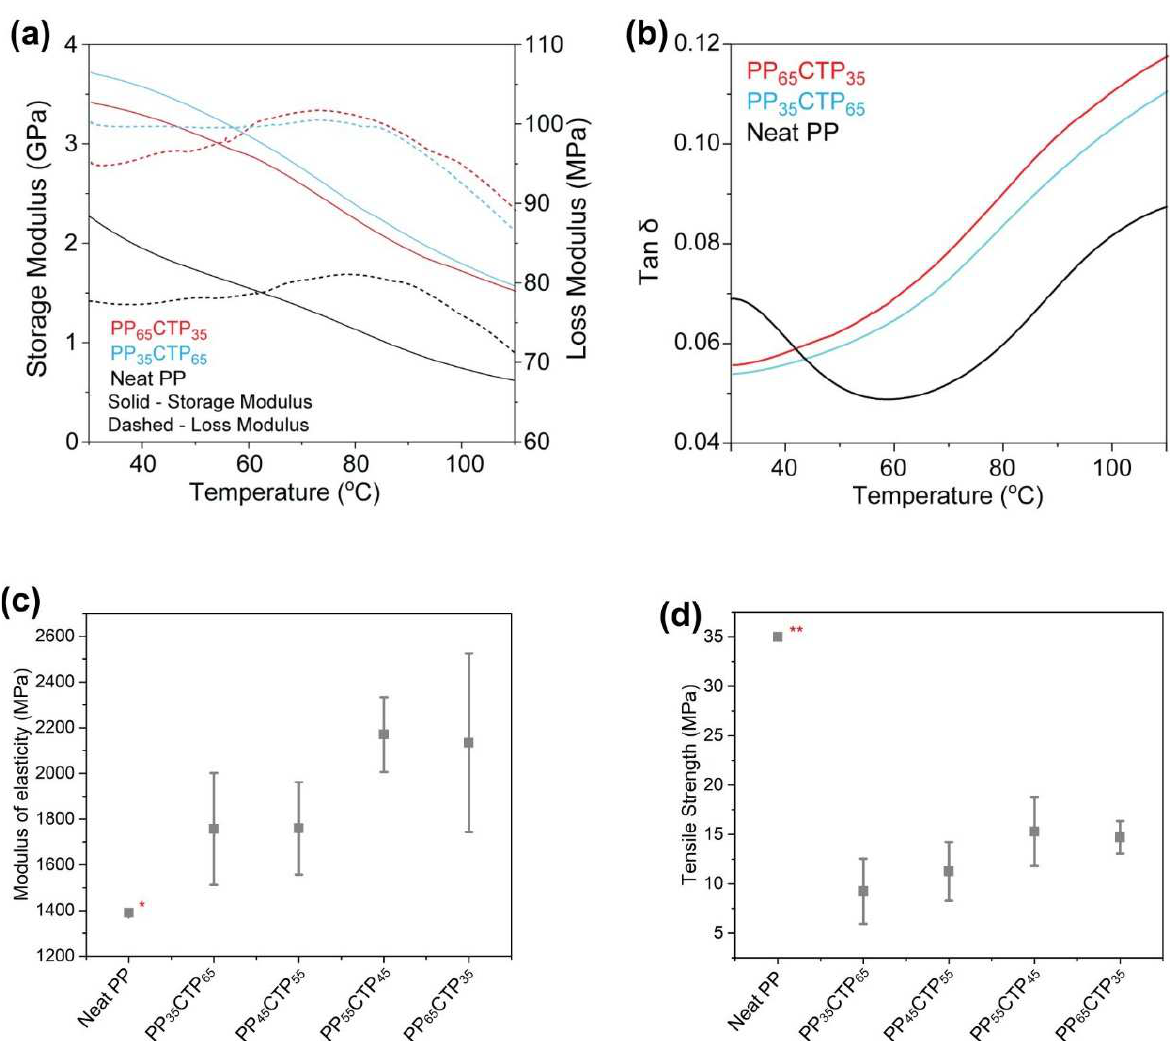
Figure 4. ( a ) Storage (E′) and loss (E″) moduli, ( b ) Tan δ curves for neat PP and PP-CTP composites, ( c ) modulus of elasticity ( d ) and tensile strength (MPa) for the PP-CTP composites. * and ** determined by Mattos et al. [27] and Sui et al. [40], respectively.